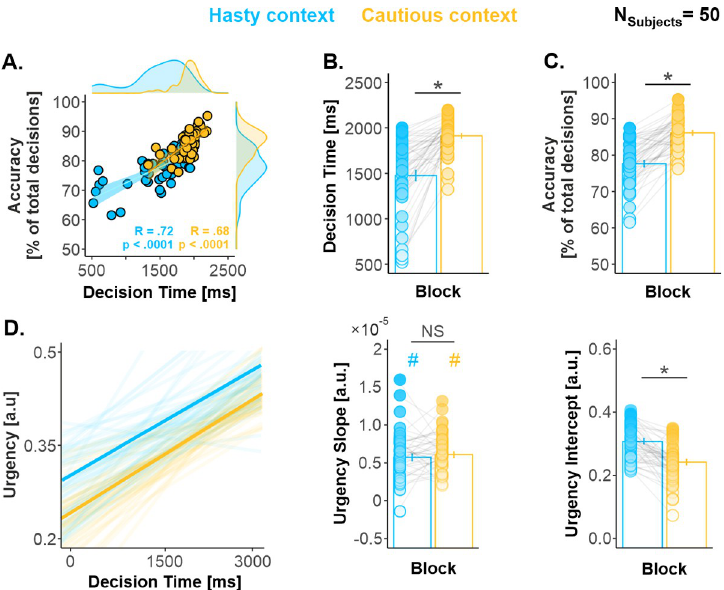
Fig 2. (related to S1 Table and S2 Fig). Participants shifted their SAT in the hasty relative to the cautious context. (A) Speed–accuracy relationship. A permutation-based correlation (N Permutations = 1,000) revealed a significant positive correlation between individuals’ DTs and accuracy, present in both contexts. As expected, the fastest participants were also the least accurate, highlighting the presence of a SAT in the task. (B) DTs. Participants presented significantly faster DTs in the hasty compared to the cautious context. (C) Decision accuracy. Accuracy was significantly lower in the hasty context. (D) Urgency functions. While the slope of the functions was comparable in the hasty and the cautious contexts (middle panel), the intercept was significantly higher in the former context. As a result, the level of urgency was higher in the hasty context throughout the deliberation period. � : significant effect of context at p < 0.05. Error bars represent 1 SEM. All individual and group-averaged numerical data exploited for Fig 2 are freely available at this link: https://osf.io/tbw7h. DT, decision time; SAT, speed–accuracy trade-off.